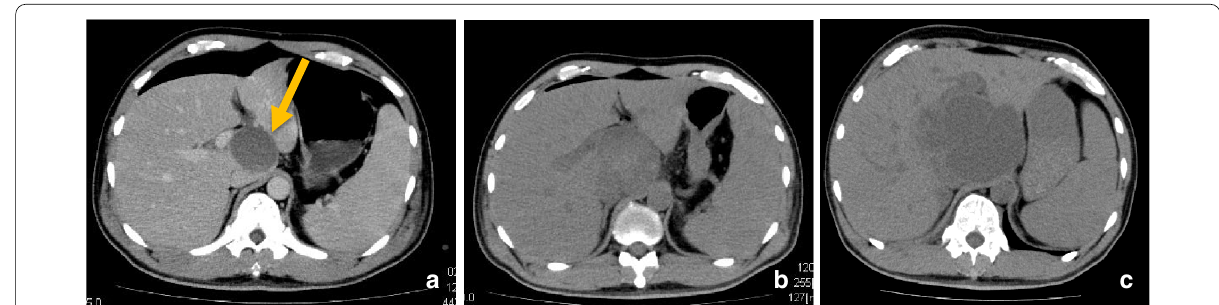
Fig. 5 Abdominal CT revealed new cystic lesions appeared in liver segment S1 ( a , arrow) and S7 (not shown) 4 days after surgery. These lesions grew rapidly 11 days after surgery ( b ). The fine needle aspiration cytology revealed that these were metastatic lesions from the undifferentiated carcinoma with rhabdoid features. Chemotherapy was ineffective and they continued to progress 47 days after surgery ( c